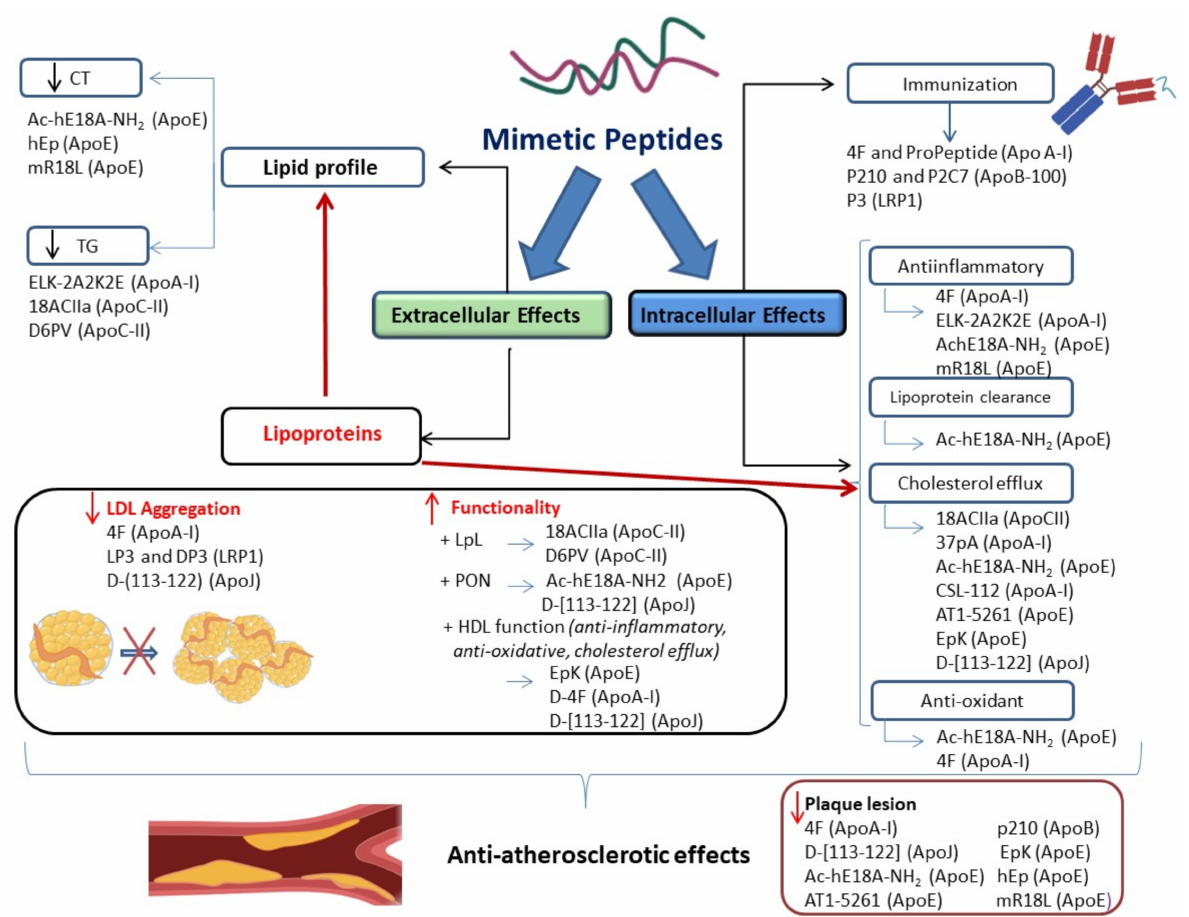
Figure 1. Schematic representation of the main extracellular and intracellular protective functions of anti-atherosclerotic peptides either used as peptidomimetics or as peptides raising